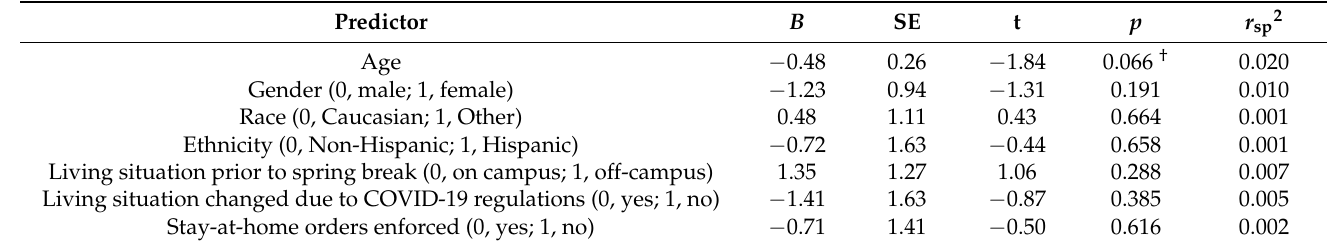
Table 1. Hierarchical multiple linear regression analysis results of living situations predicting fear of COVID-19.